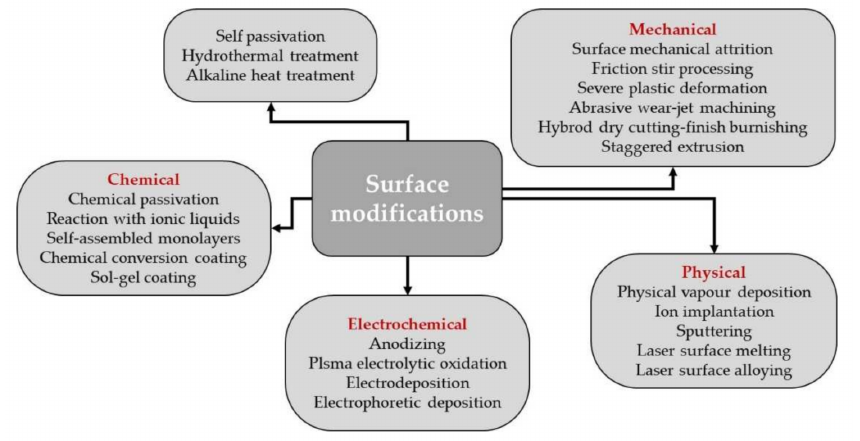
Figure 2. Schematically representation of the surface modifications that can be applied in the case of Mg based